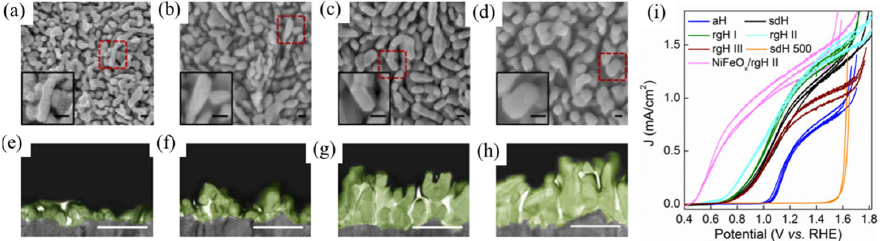
Figure 1. Morphology evolution of hematite as a result of the re ‐ growth treatments. Scanning elec ‐ tron micrographs image of ( a ) sdH, ( b ) rgH I, ( c ) rgH II and ( d ) rgH III; scale bars, 100 nm. Magnified views of selected areas in the main frames are presented in the insets. Transmission electron micro ‐ graphs of focused ion beam prepared cross ‐ sectional samples of ( e ) sdH, ( f ) rgH I, ( g ) rgH II and ( h ) rgH III, scale bars, 500 nm. ( i ) Comparison of PEC performances of aH, sdH, rgH I, rgH II, rgH III and NiFeOx/rgH II samples. The photocurrents of sdH 500 (annealed at 500 °C) were less than 10 μ